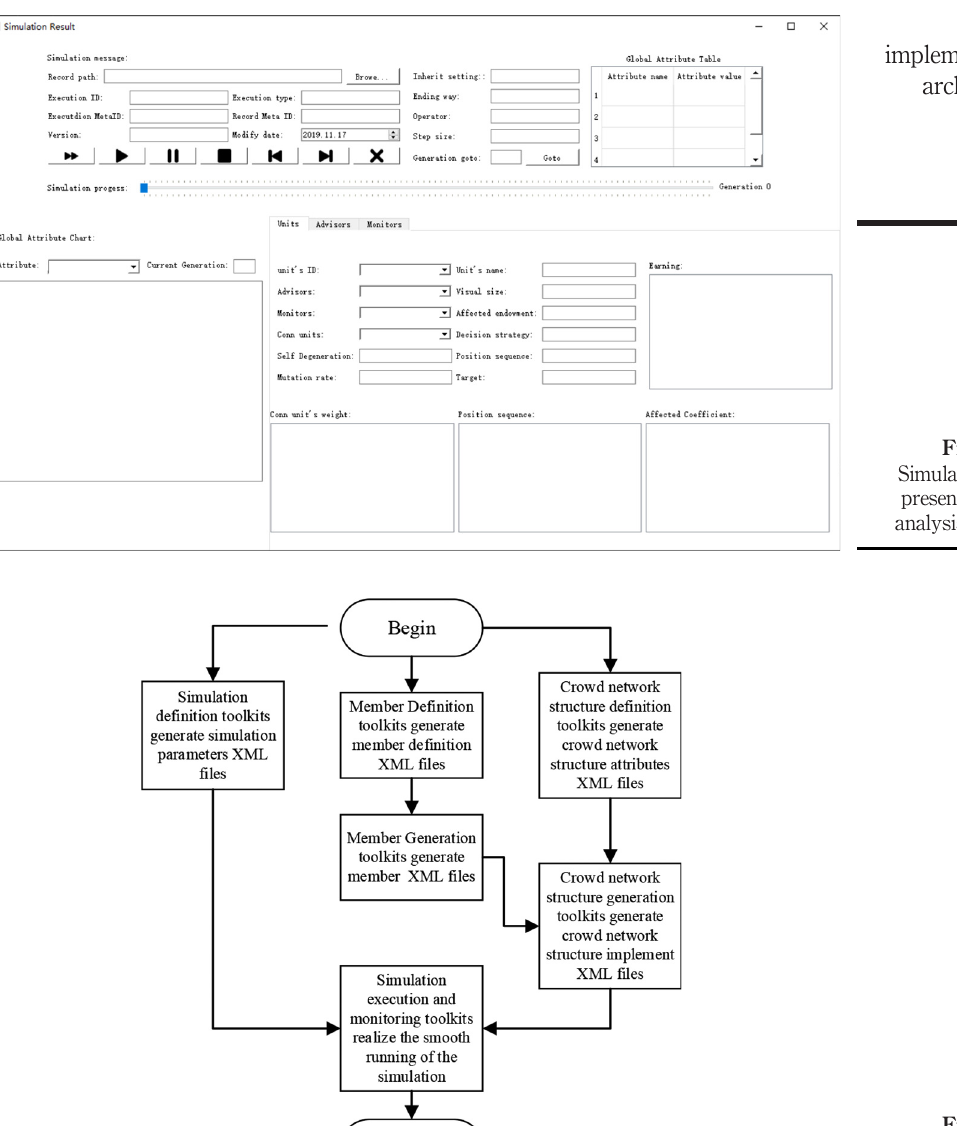
Figure 17. Simulation fl